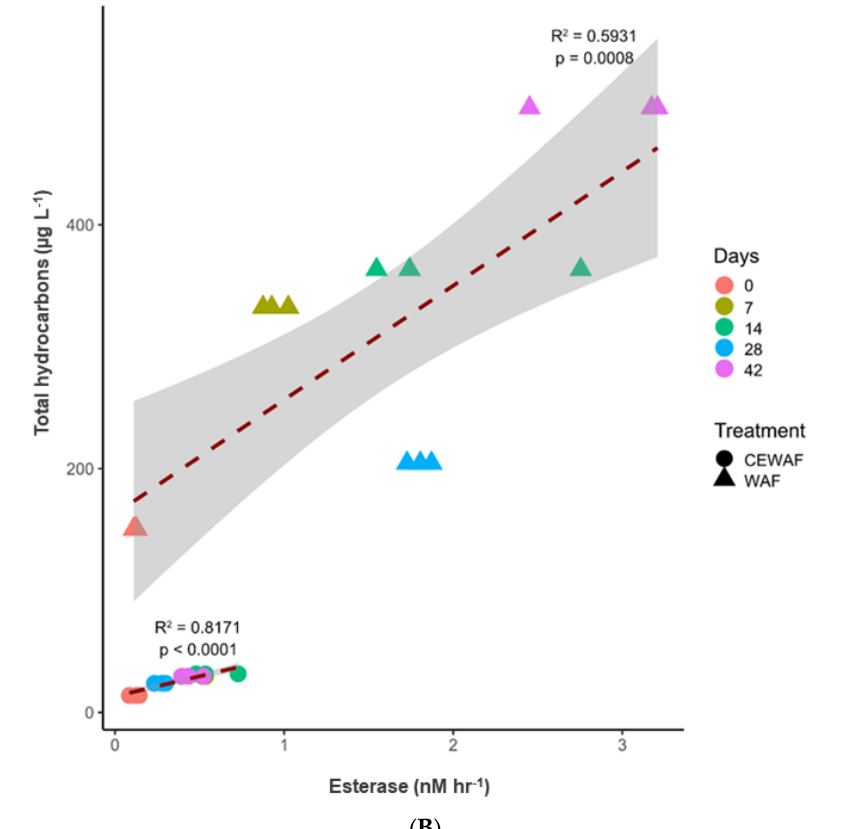
Figure 2. Esterase activities measured by means of MUF butyrate hydrolysis and oil concentrations in the deep-water incubation (case study 2). ( A ): Time courses of esterases (average rates of n = 3; ± standard deviations) in the two oil treatments (WAF, CEWAF) and the non-oil control water. ( B ): Correlation between lipases and total hydrocarbons. Note that hydrolysis rates of the three replicates were plotted in B. All of the data in this figure are replotted from [45]. Table 4. Pearson correlation coefficient (r 2 ) and p -values for deep water lipase activities and hydrocarbons. Hexadecane n -Alkanes Naphthalene Phenanthrene − WAF